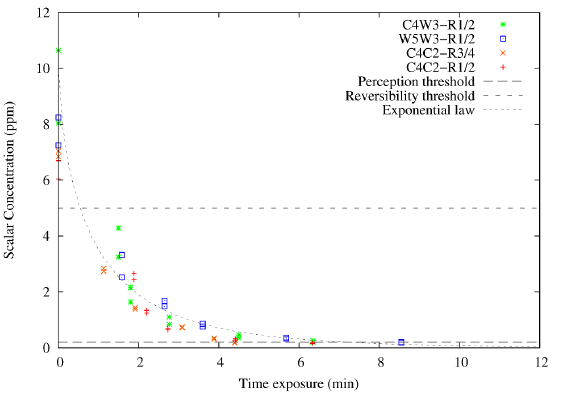
Figure 9. Estimate of the population exposure as a function of the NO 2 concentration and the exposure time. The colour code and symbol style indicate the simulation type. Two thresholds are given by Tissot and Lafon